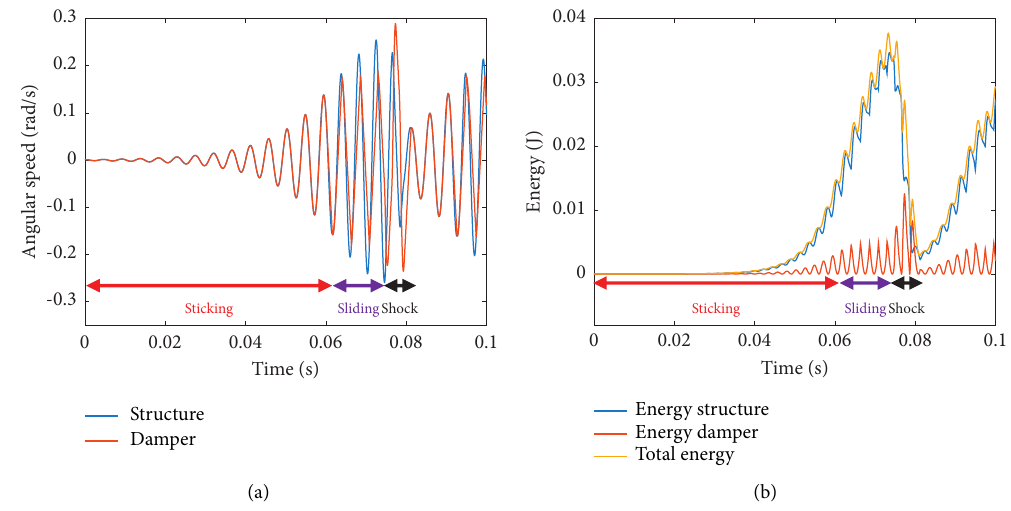
Figure 7: Time response of the damper and the structure (a); energy flow within the system